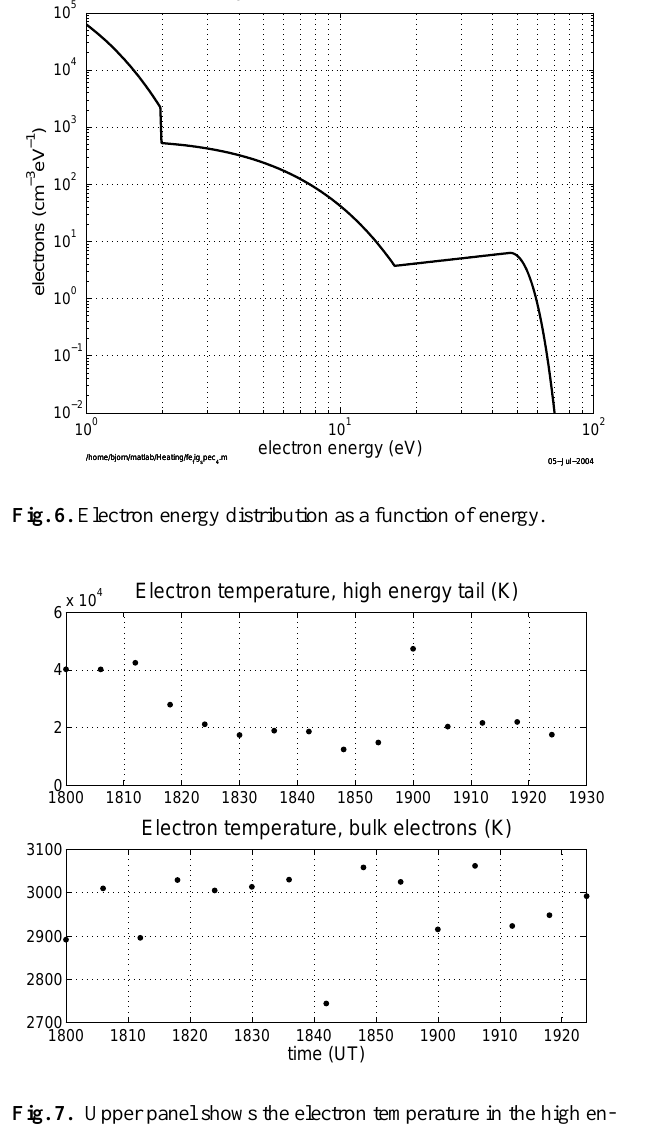
Fig. 7. Upper panel shows the electron temperature in the high en- ergy tail, from 2eV to approximately 20eV. For comparison the lower panel displays the EISCAT UHF measurements of ( T e ) at steady state in the region of highest temperature.